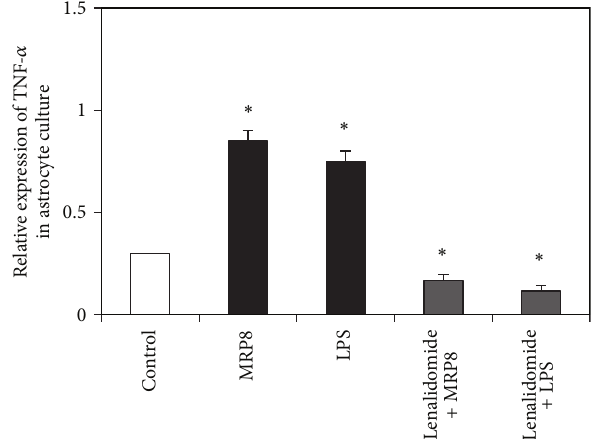
Figure 2: qPCR results showed significant upregulation of TNF- 𝛼 in the astrocytes after stimulation with LPS and MRP8 and sig- nificant downregulation after inhibition with lenalidomide (TNF- 𝛼 inhibitor) compared to stimulated